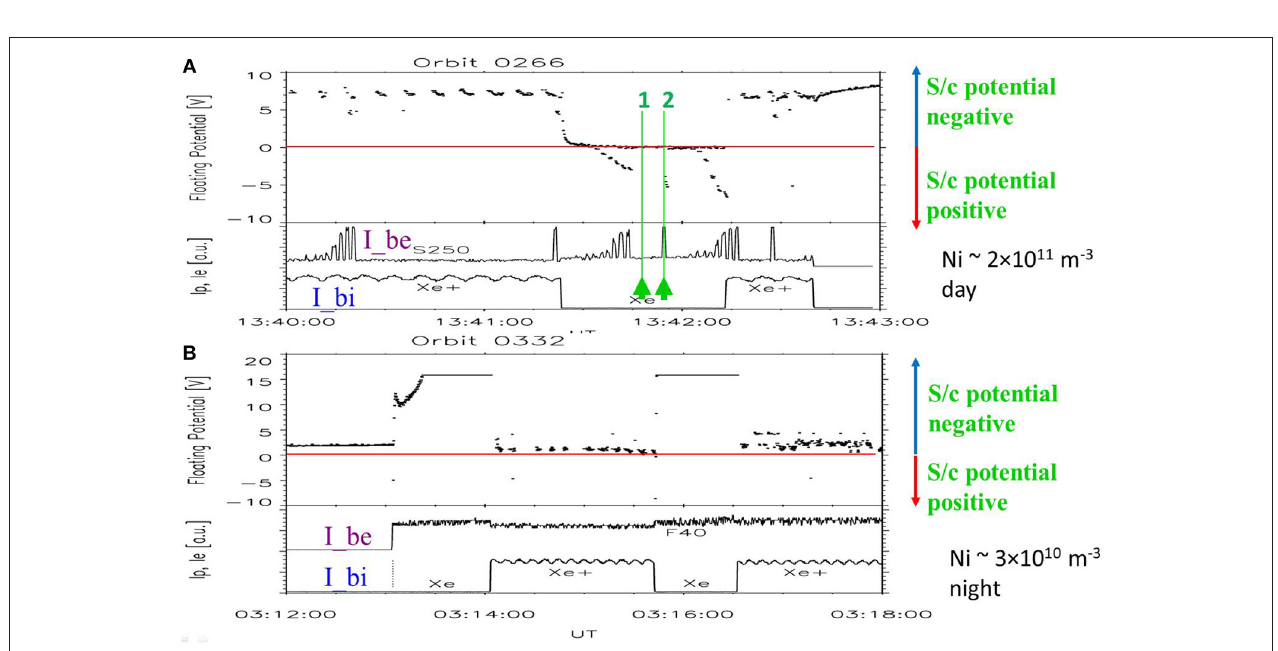
FIGURE 5 | IK–25 spacecraft potential outside of active experiment intervals. The plots show the potential difference between the KM–10 floating probe and the spacecraft body as a function of the altitude (A) and the ambient plasma density (B) . The spacecraft is charged negatively for positive KM–10 floating potentials. (Reprinted from Prech et al., 1999, with permission from Elsevier).